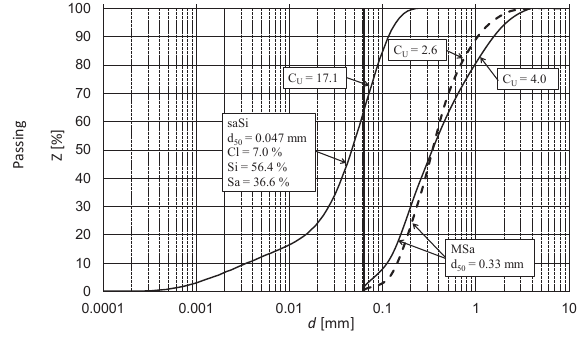
Fig. 4. The granulometric composition of the studied soils. Figure 4: The granulometric composition of the studied soils. Table 2. Parameters of tested samples